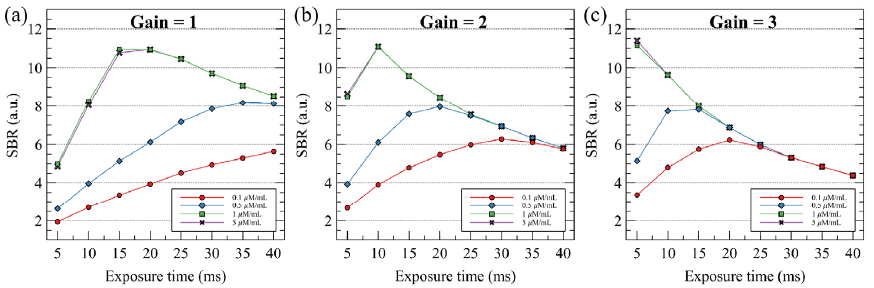
Figure 5. Background average gray level in different gain ( a ) and lighting conditions ( b ). ( a ) Back- ground noise measured with 12 W LED lights and room lights on. ( b ) Background image measured with gain of 1.